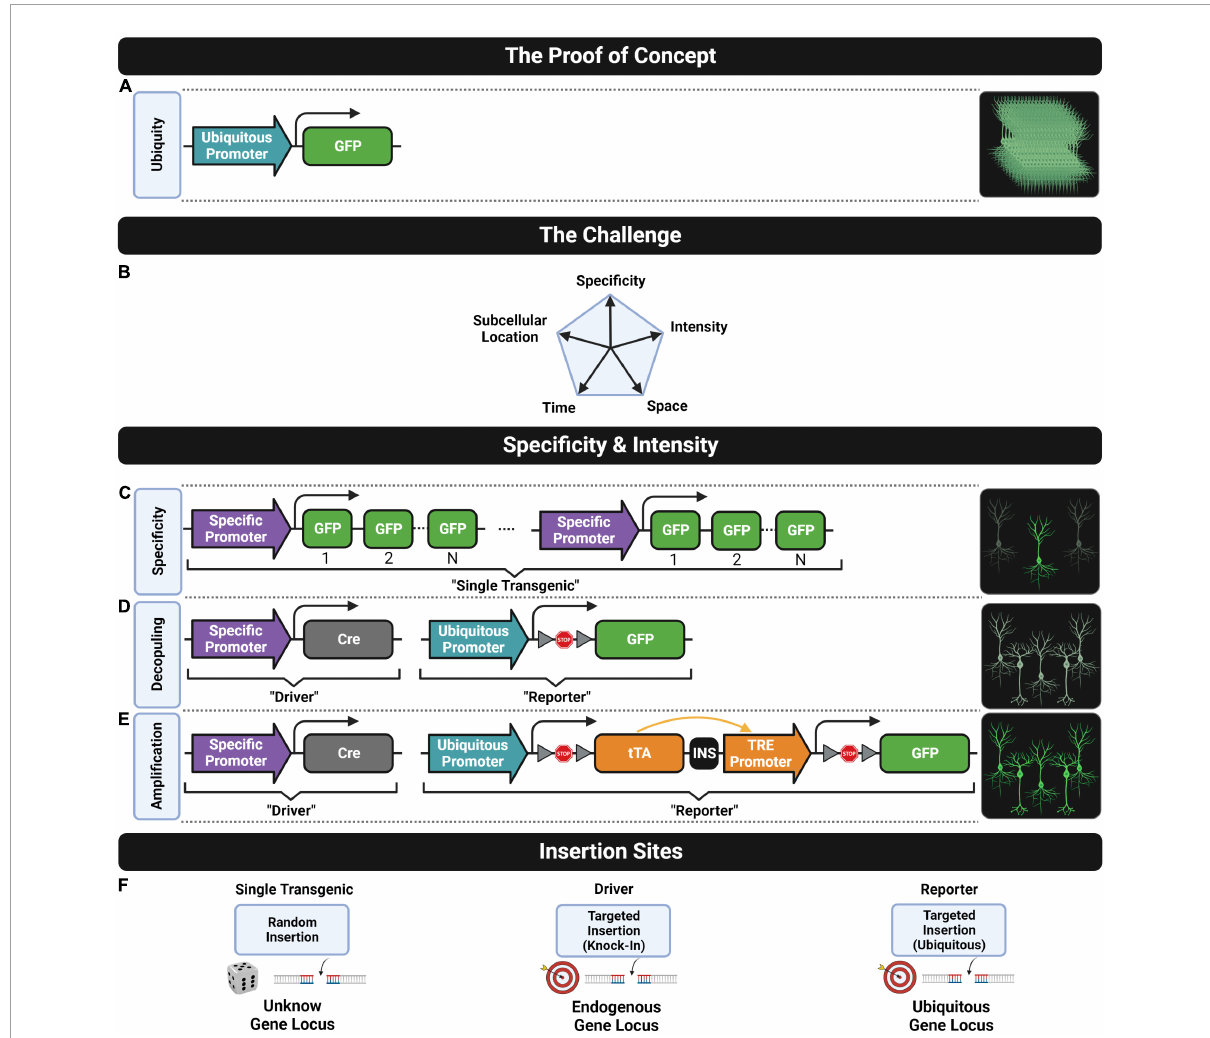
FIGURE2 Fluorescent transgenic models. (A) The construct design that leads to the ubiquitous cell expression of the green FP as the proof-of-concept model known as the “green mice”. (B) The challenge of developing genetic tools for controlling five fundamental features of transgene expression for neuroscience research. Cell-type specificity can be achieved through (C) a single or (D) a double transgenic strategy. The intensity of the fluorescent signal can be increased through (C) including multiple transgene repeats, (D) using a stronger ubiquitous promoter or (E) amplifying the expression of a single transgene copy. (F) Common insertion sites of transgene constructs into the genome for generating lines following (left) the single or (middle and right) the double transgenic